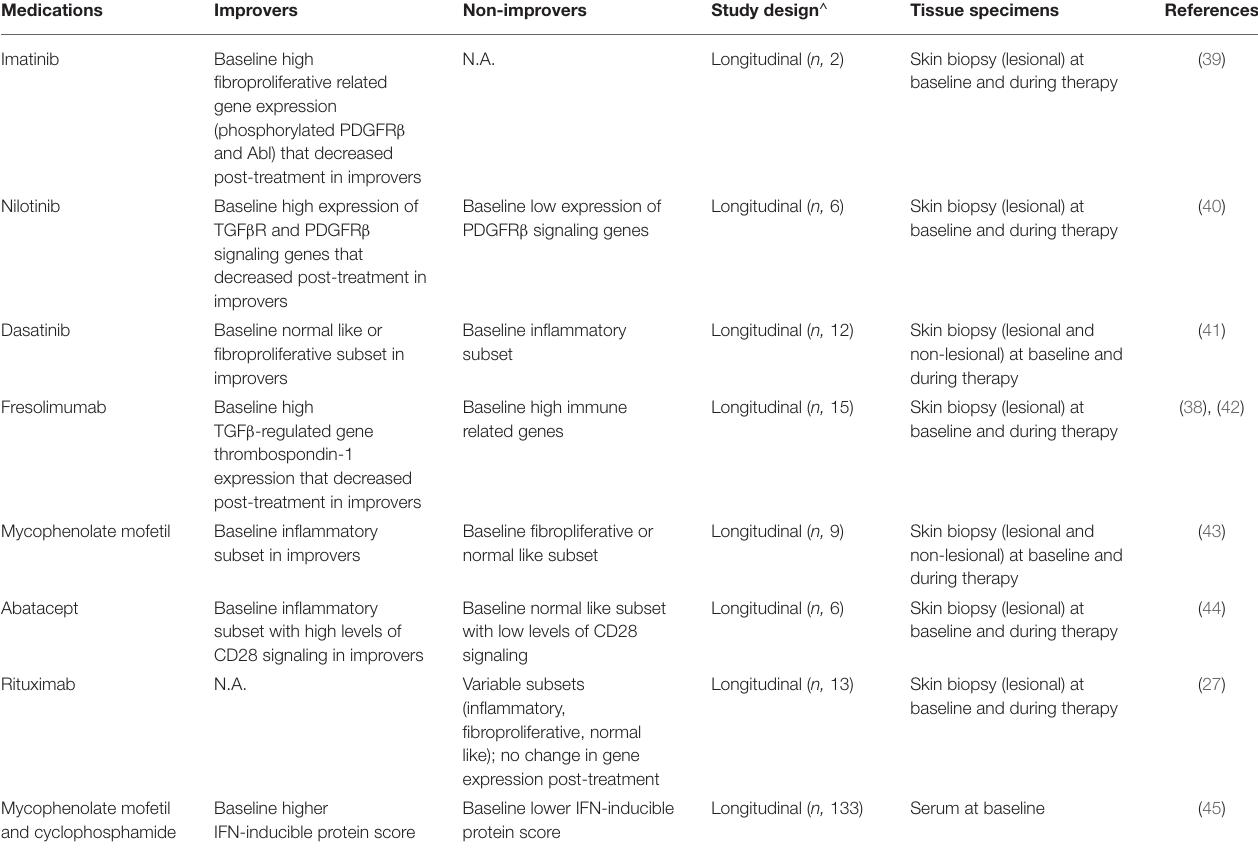
TABLE 2 | Stratification in relation to treatment